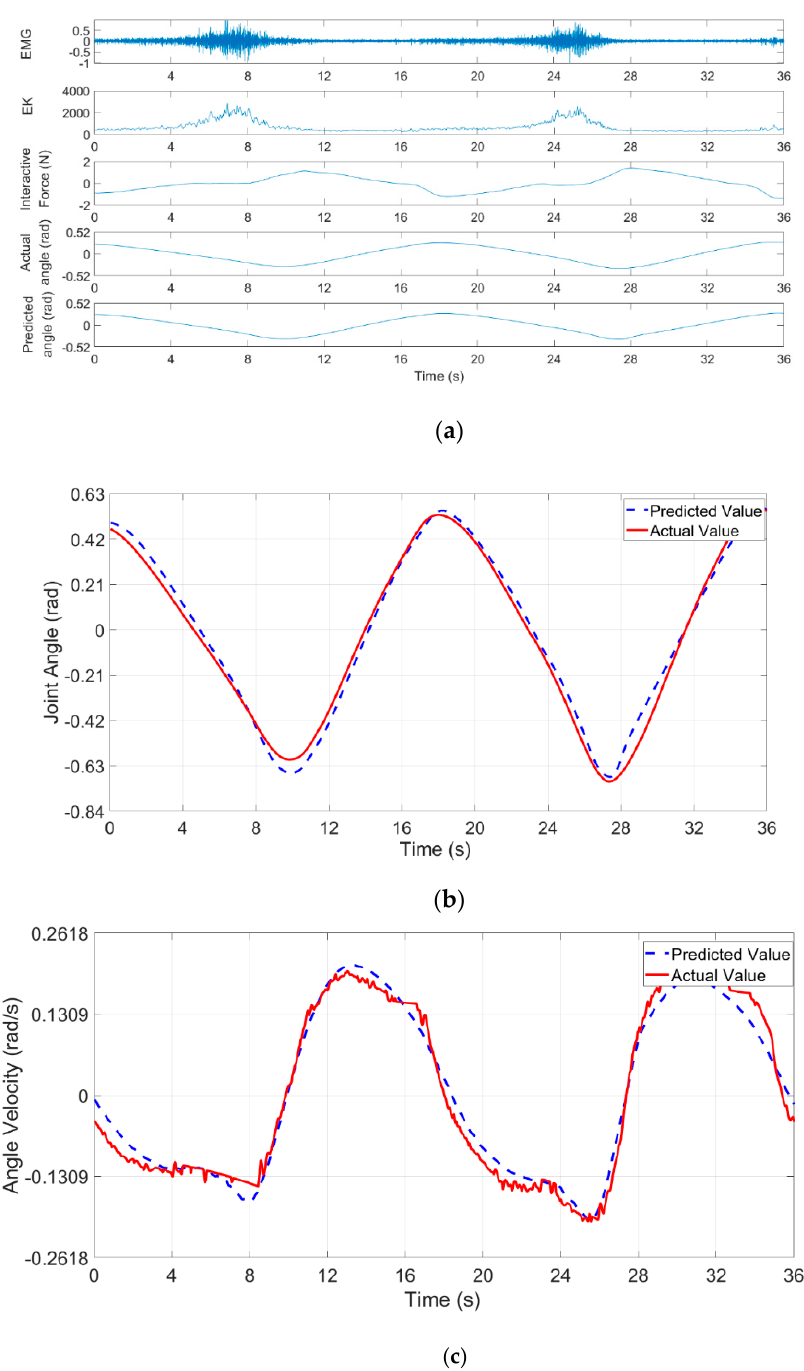
Figure 10. A typical set of experimental results. ( a ) The raw EMG signals from RF, the extracted energy kernel feature (EK), the interactive force, the actual angle and the predicted angle are listed from top to bottom; ( b ) The results of predicted and actual joint angle; ( c ) The results of predicted and actual joint angular velocity.